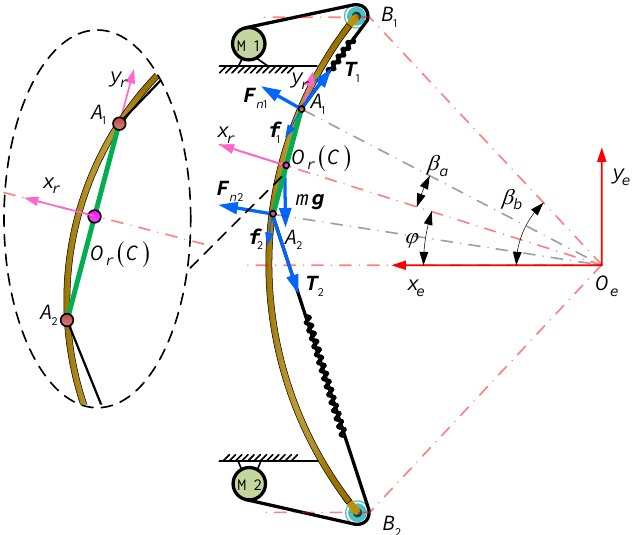
Figure 2. Force exerted on the moving platform of the twin-motor cable driven